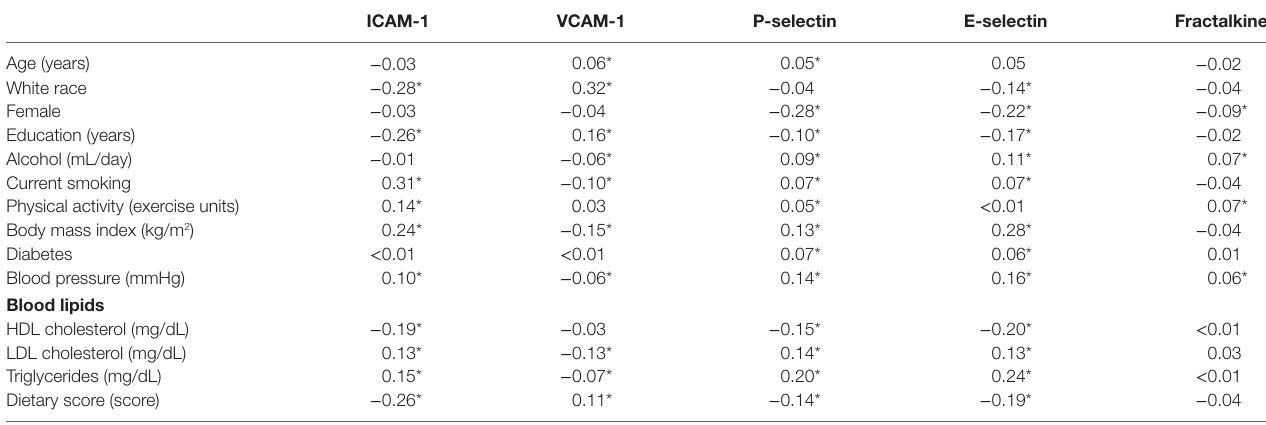
Table 2 | Pearson correlation coefficients between year 7 circulating cellular adhesion molecules and other variables measured at year 7.